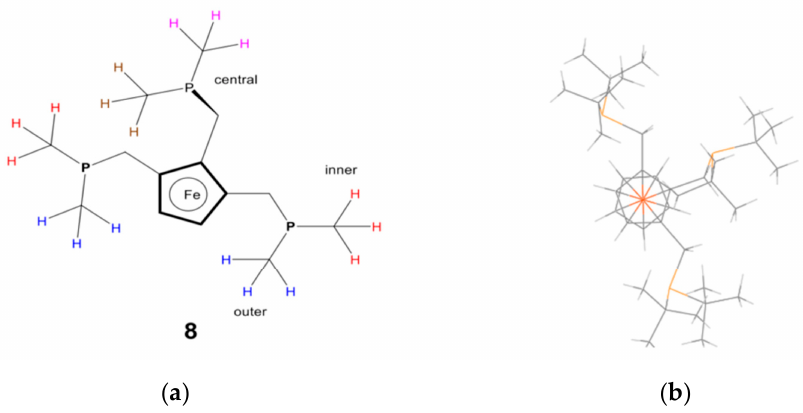
Figure 8. Tris-phosphane 8 from above the cyclopentadienyl ferrocene ring plane: ( a ) schematic and ( b ) stick diagram, obtained from the crystal structure of 8 .